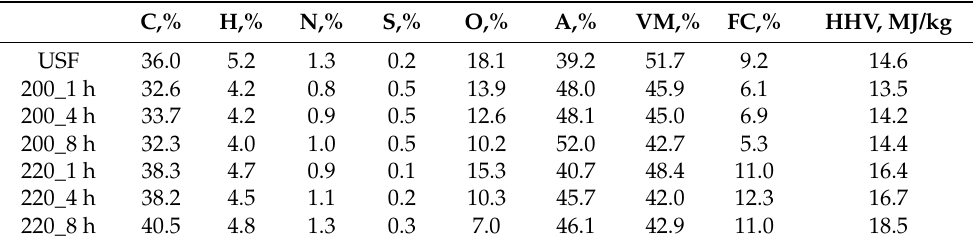
Figure 4. Composition of the under-sieve fraction of municipal mixed waste. Table 1. Results of ultimate and proximate analysis